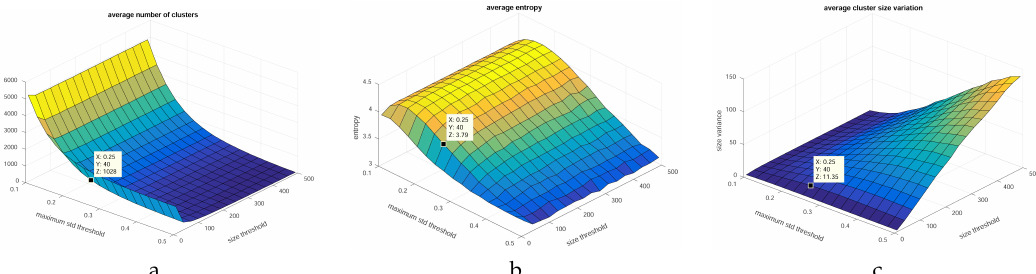
Figure 4. Grid-search for optimal stopping criteria with respect to different cluster properties: ( a ) average number of clusters, ( b ) average entropy, ( c ) cluster size variation. The selected point is a tradeoff between processing time, variability and cluster